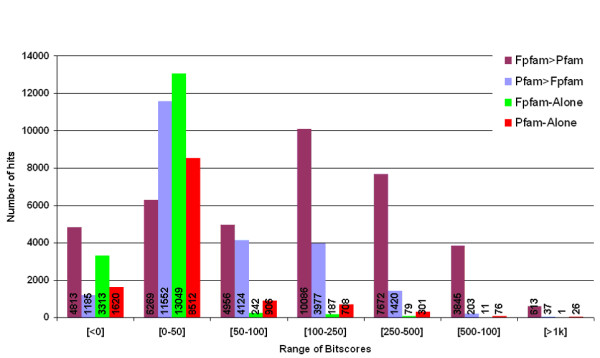
Comparison of bitscore from Fpfam and Pfam HMM libraries in five genomes. The X-axis shows different ranges of bitscores for which the frequency of FPfam>Pfam, Pfam>FPfam, no-Pfam and no-FPfam is calculated. To avoid frequencies being counted twice in cases where both Pfam and FPfam results are available, only the maximum score is assigned its respective bin. Generally, FPfam reports a higher bitscore.